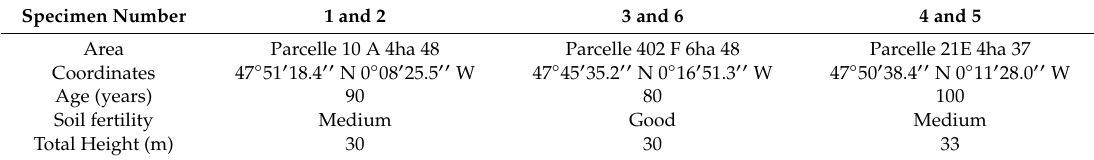
Table 1. Characteristics of oak trees ( Quercus petreae ) from R é gion Pays de la Loire, France. Specimen